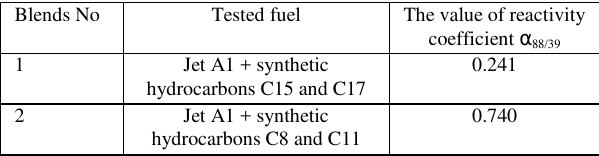
Table 2. Results of reactivity coefficient a i calculation for two synthetic components